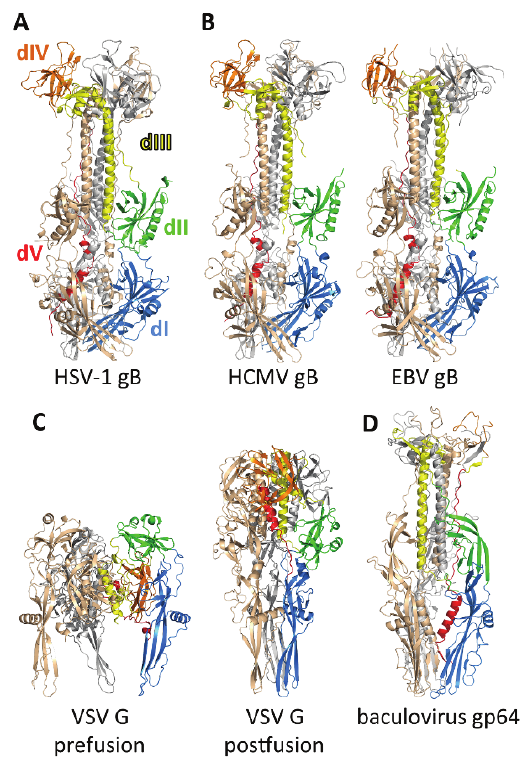
Figure 5. The crystal structures of class III viral fusogens. HSV-1 gB (PDB ID 2GUM), CMV gB (PDB ID 5CXF), EBV gB (PDB ID 3FVC), and baculovirus gp64 (PDB ID 3DUZ) are shown in the postfusion conformations. VSV G is shown in both prefusion and postfusion conformations (PDB ID 2J6J and 2CMZ). A single protomer is each structure is colored by domain: dI, blue; dII, green; dIII, yellow;